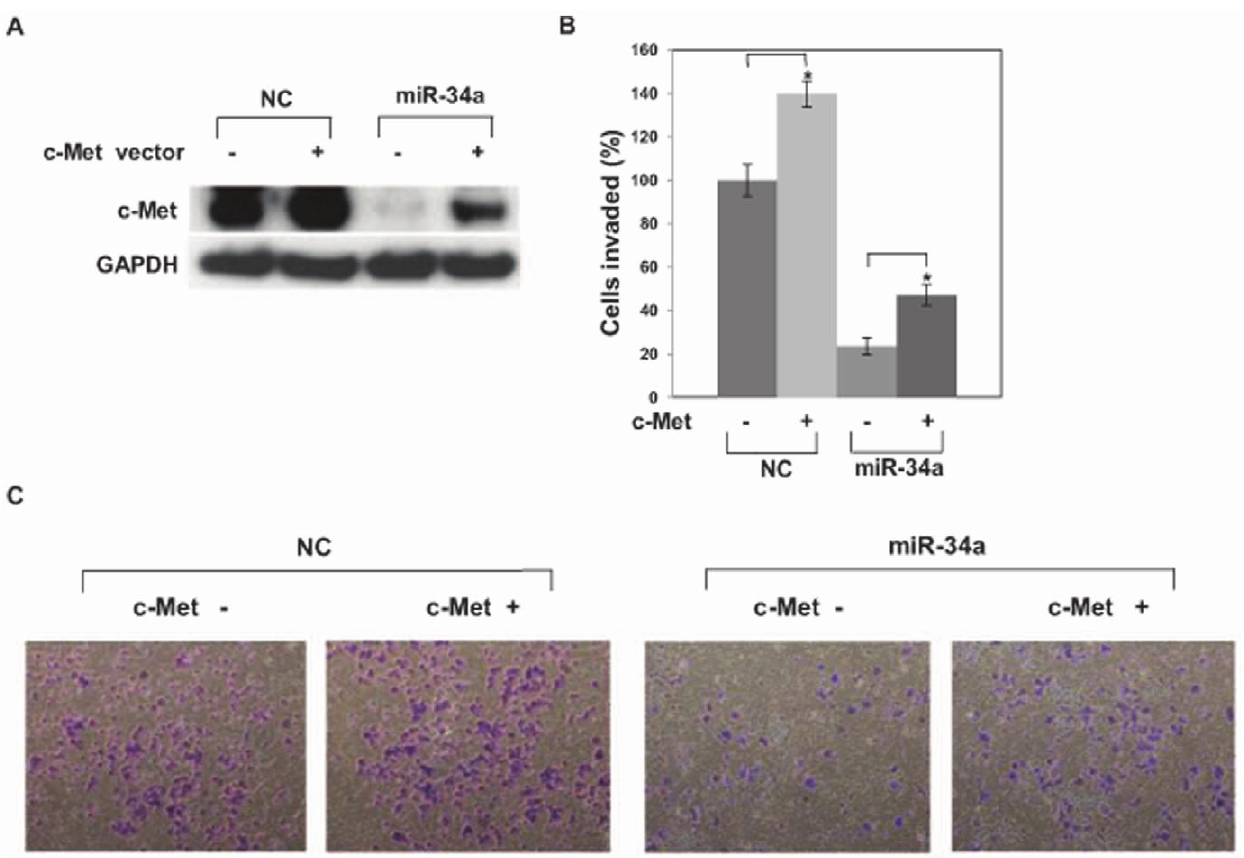
Figure 7. c-Met overexpression partially rescues suppression of cell invasion by miR-34a. (A) PC-3 cells were transiently transfected with pCMV6-ENTRY only or pCMV6-ENTRY-c-Met for 8 h followed by transient transfection with pre-miR negative control (NC) or pre–miR-34a for 72 h. Protein level was analyzed by Western blot. (B) c-Met expression partially rescues inhibition of invasion induced by miR-34a. PC3 cells were transiently transfected with pCMV6-ENTRY only (control) or pCMV6-ENTRY-c-Met for 8 h followed by transfection with pre-miR negative control (NC) or pre–miR-34a for 48 h. The cells were harvested and subjected to transwell invasion assay. *, P , 0.05 compared with control. (C) Representative images of invaded cells.